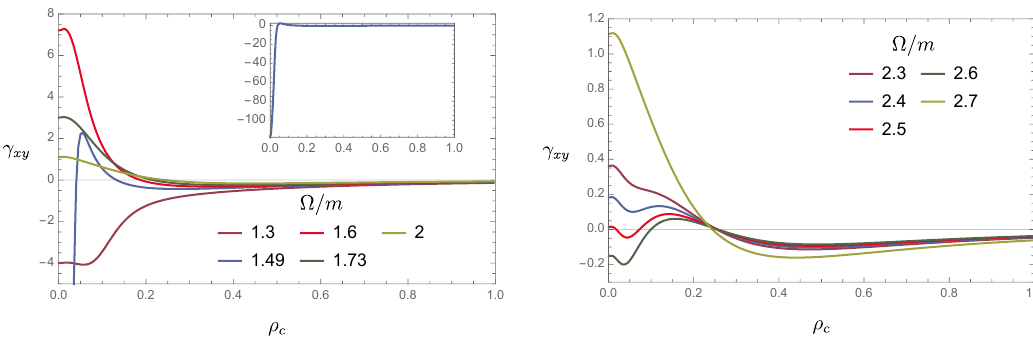
Figure 8 . The susceptibility coe(cid:14)cient (cid:13) xy as a function of (cid:26) c for black hole embeddings and di(cid:11)erent driving frequencies. On the left we plot the values for frequencies close to the (cid:12)rst critical resonant frequency (cid:10) c =m = 1 : 49. On the right we represent (cid:13) xy for driving frequencies around (cid:10) =m = 2 : 5, which is frequency of the (cid:12)rst zero of j for critical embeddings.